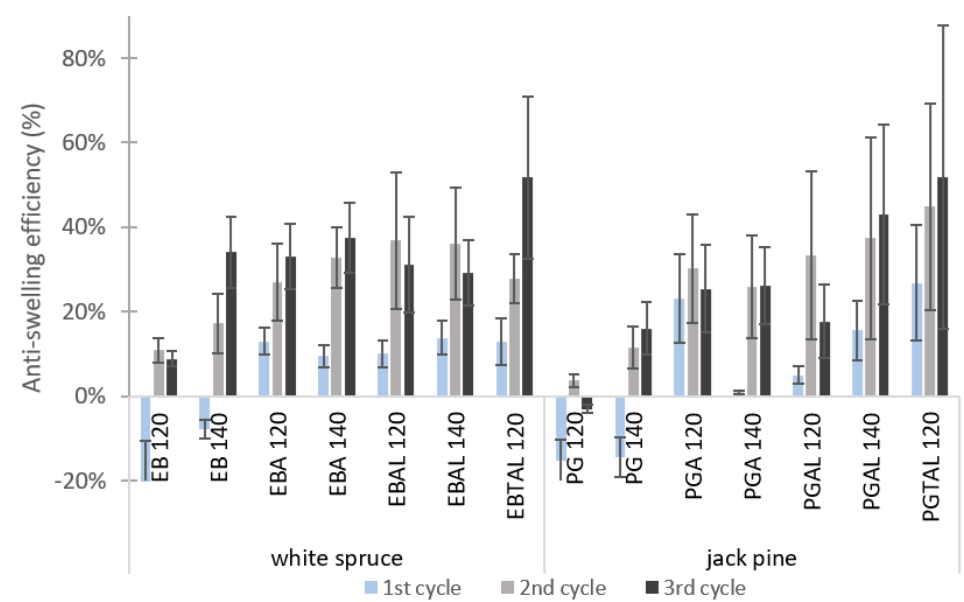
Figure 2. ASE v to humidity for the different treatments on white spruce and jack pine after three cycles.